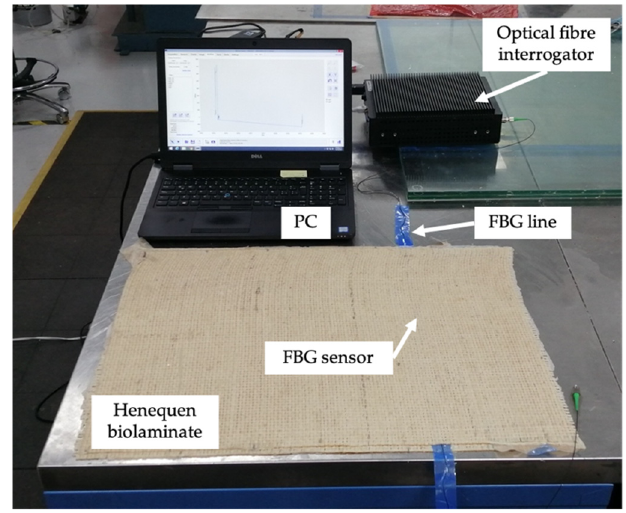
Figure 1. VARI setup for monitoring biocomposite fabrication with FBG optical fiber.